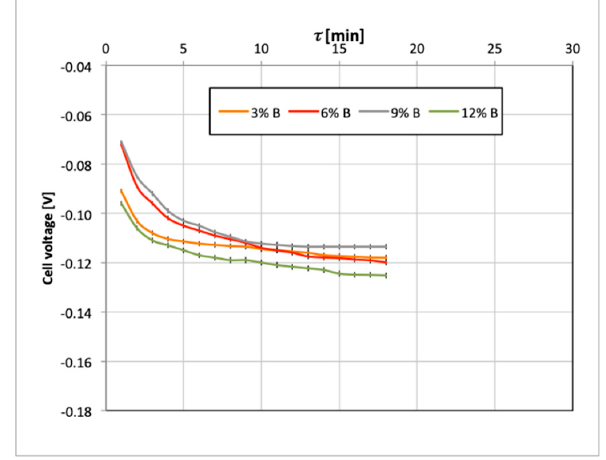
Figure 3. The electroless potential of electrodes with Cu–B catalyst which were oxidized for 3 h.